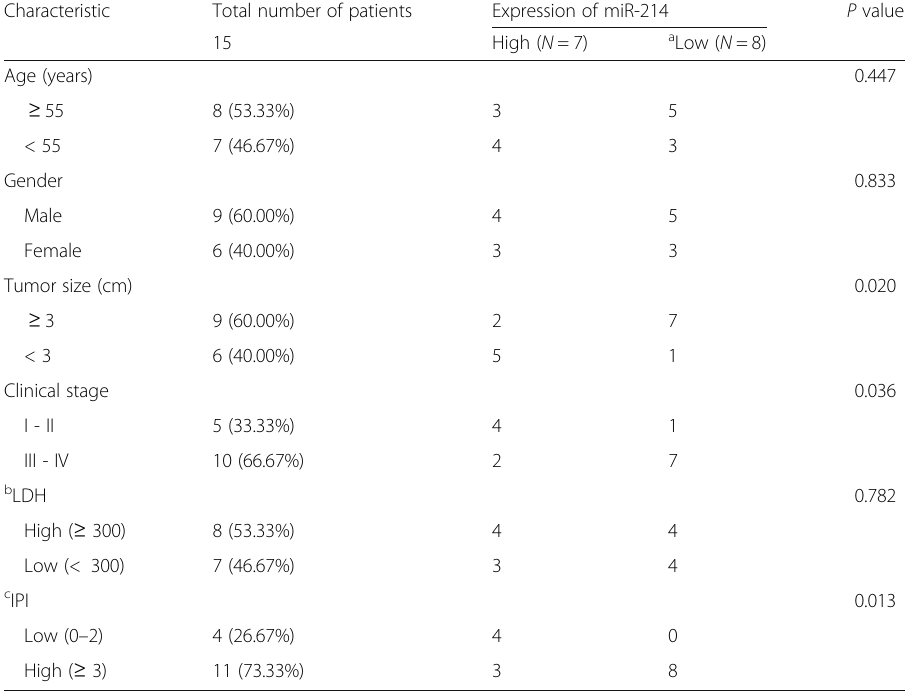
Table 2 The clinicopathological features of patients with DLBCL Characteristic Total number of patients